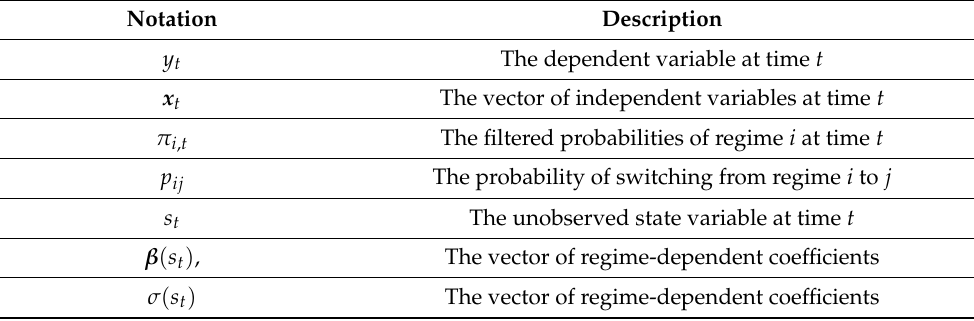
Table 1. Main notation